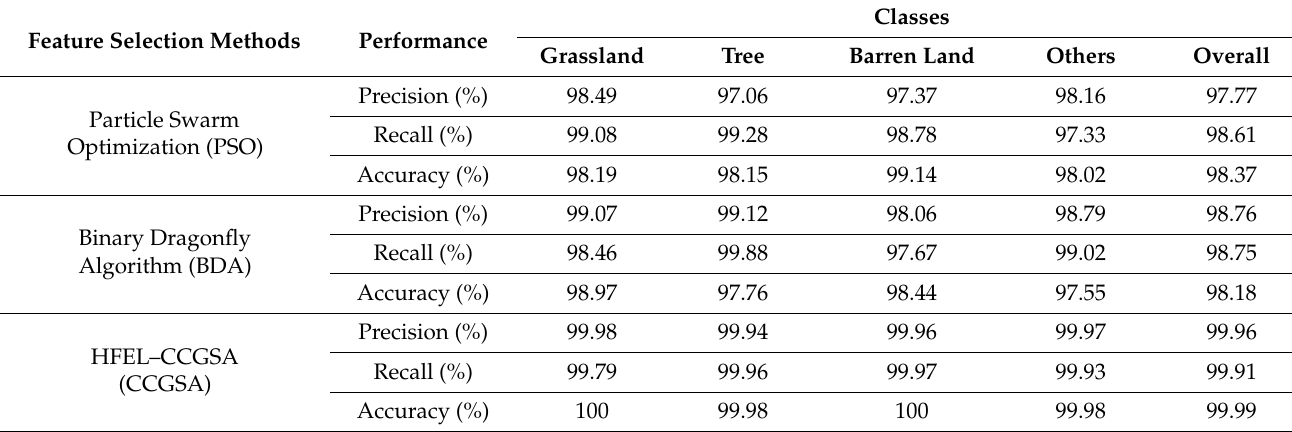
Table 3. Performance analysis for different feature selection methods and HFEL–CCGSA on SAT-4 dataset. Feature Selection